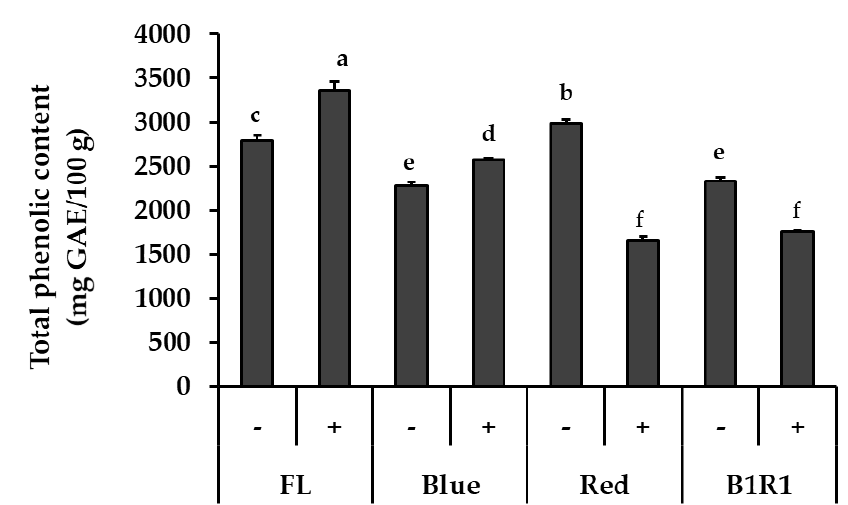
Figure 2. Total phenolic content of microgreens cultivated in the absence ( − ) and presence (+) of salt and exposed to fluorescent (FL), blue, red and combination of blue plus red (B1R1) light. Data were expressed as mean ± standard error ( n = 3) in milligram(mg) gallic acid equivalent (GAE) per 100 g (g) of the extracts dry weight (DW). ANOVA analysis was done using Duncan’s method and differ‐ ent letters (a – f) were used to show statistical significance ( p < 0.05).